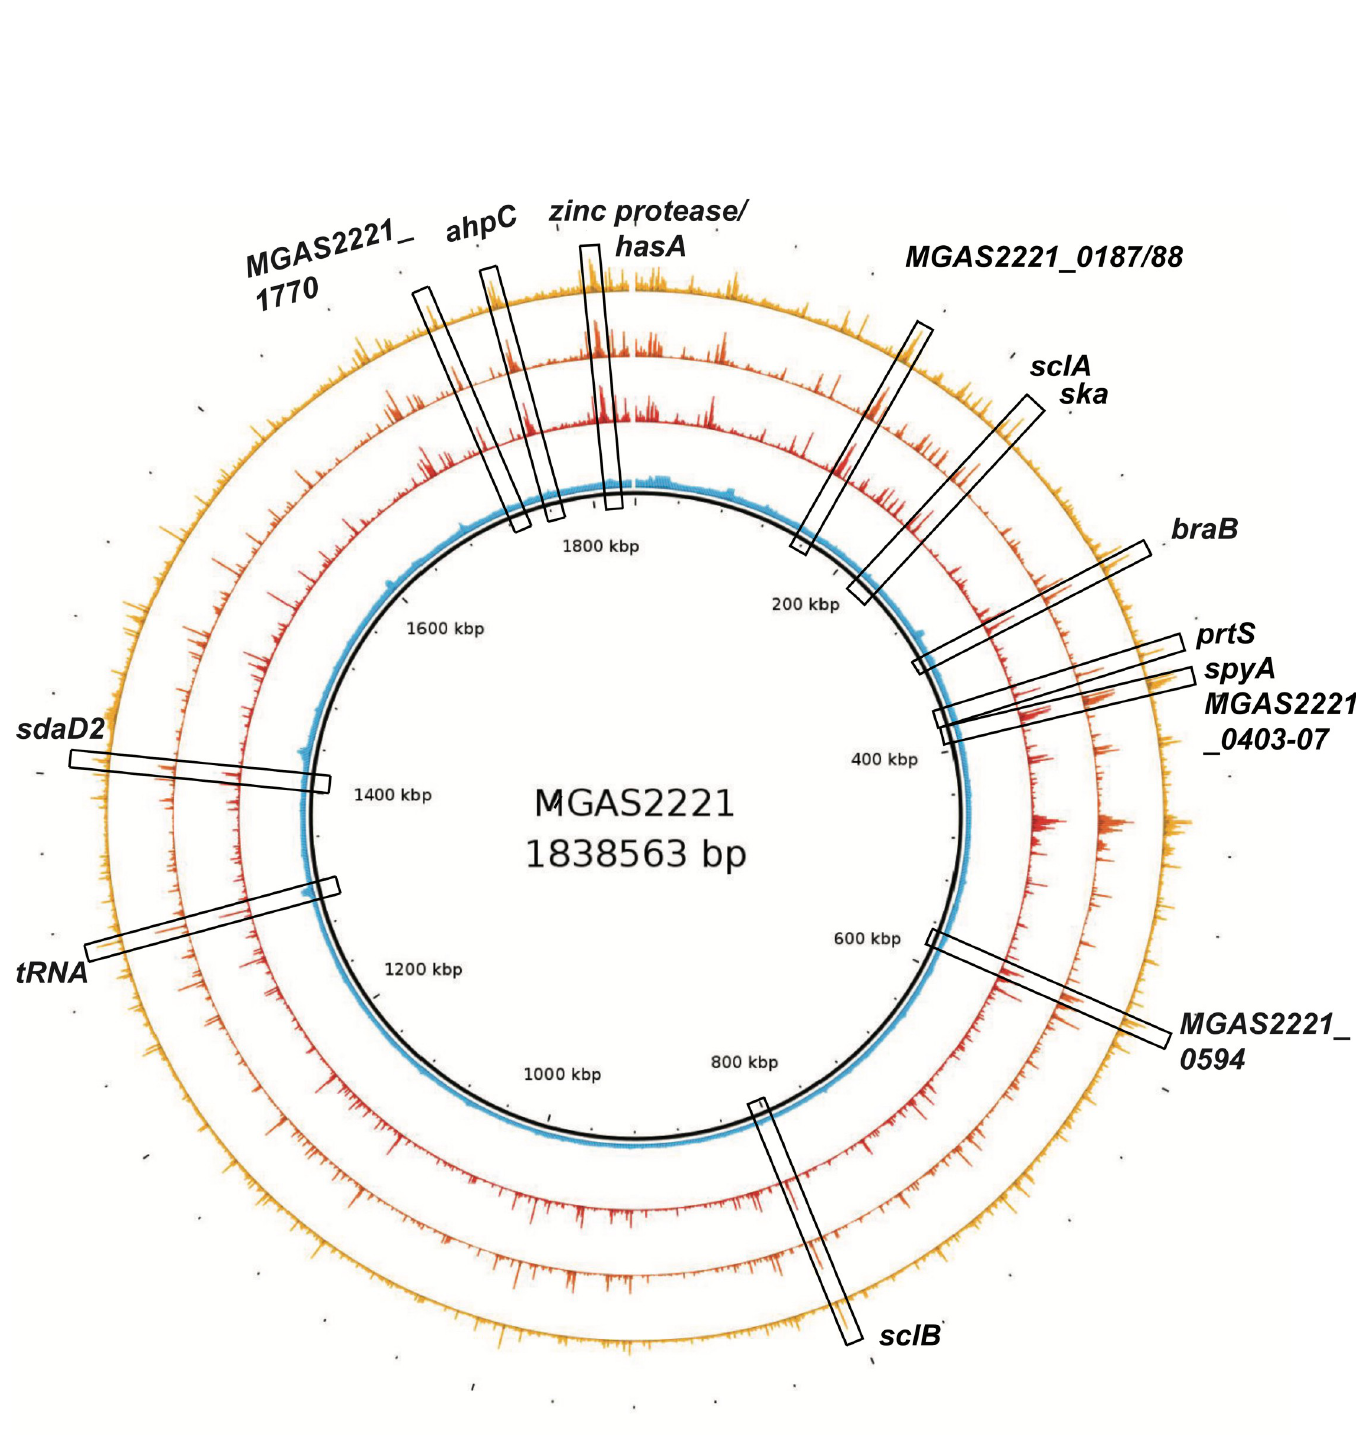
Fig 2. Genomic location of CovR binding sites. Map of the MGAS2221 genome with distribution of sequencing reads obtained from ChIP-seq. Sequencing reads of three representative samples of MGAS2221 (shown in yellow, orange, and red) and one 2221 Δ covR control sample (shown in blue) are depicted. Representative peaks (enriched sequencing reads) at strongly enriched promoters (RPKL > 500) are highlighted in boxes and labeled. Gene numbers refer to open reading frames from the MGAS2221 genome (NZ_CP043530.1). Note, that strain MGAS2221 has a chromosomal inversion relative to strain MGAS5005 resulting in altered location of ska .